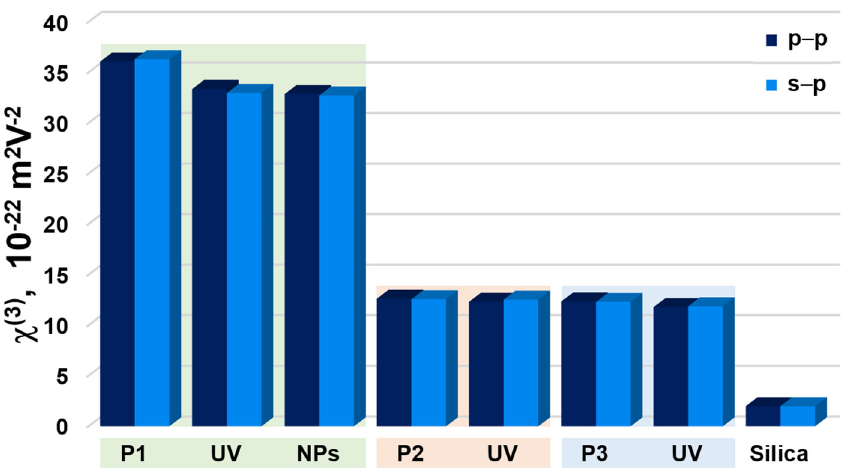
Figure 9. Histogram representing values of χ (3) in s–p and p–p laser beam of polymer P1, P2, and P3 after UV–irradiation (UV), with ZnO nanoparticles (NPs), and comparison with reference material silica glass.